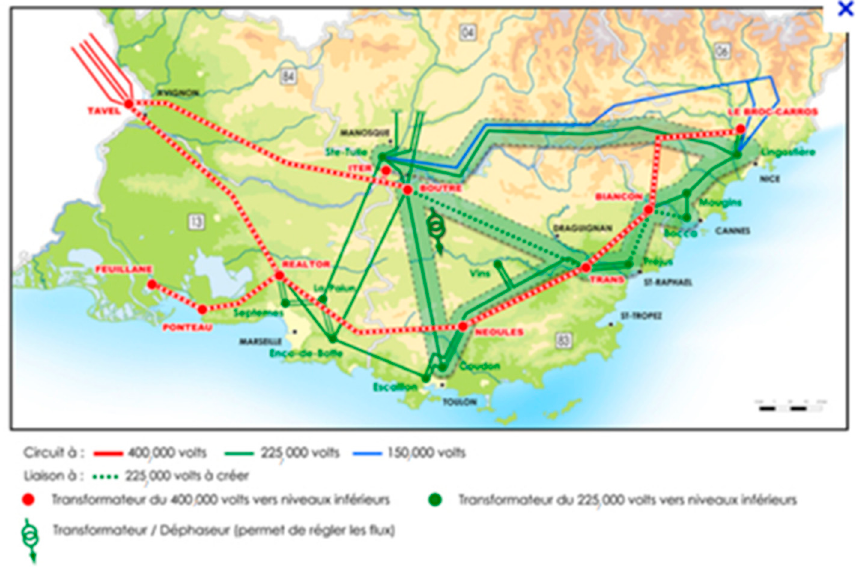
Figure 5. Electricity transmission network (high voltage).